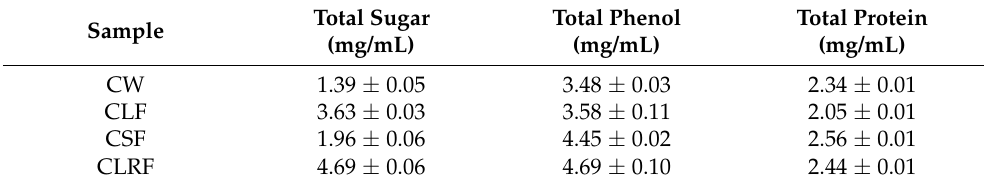
Table 3. Active substance content of the fermentation broth of three species of Coix